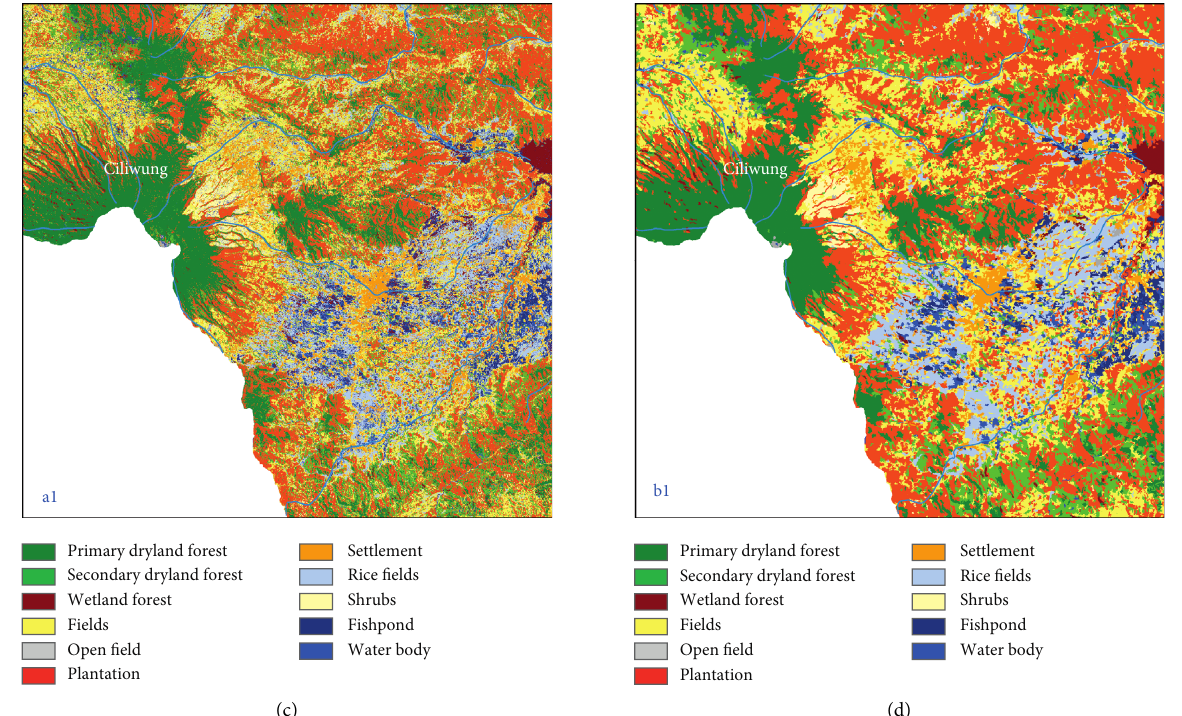
Figure 5: Result of the LULC classification based on the ML classifier: (a, c) process stages without the MaSegFil approach; (b, d) process stages with the MaSegFil approach. Table 2: Results of the accuracy assessment for the LULC classification based on the ML classifier without the MaSegFil approach. LULC